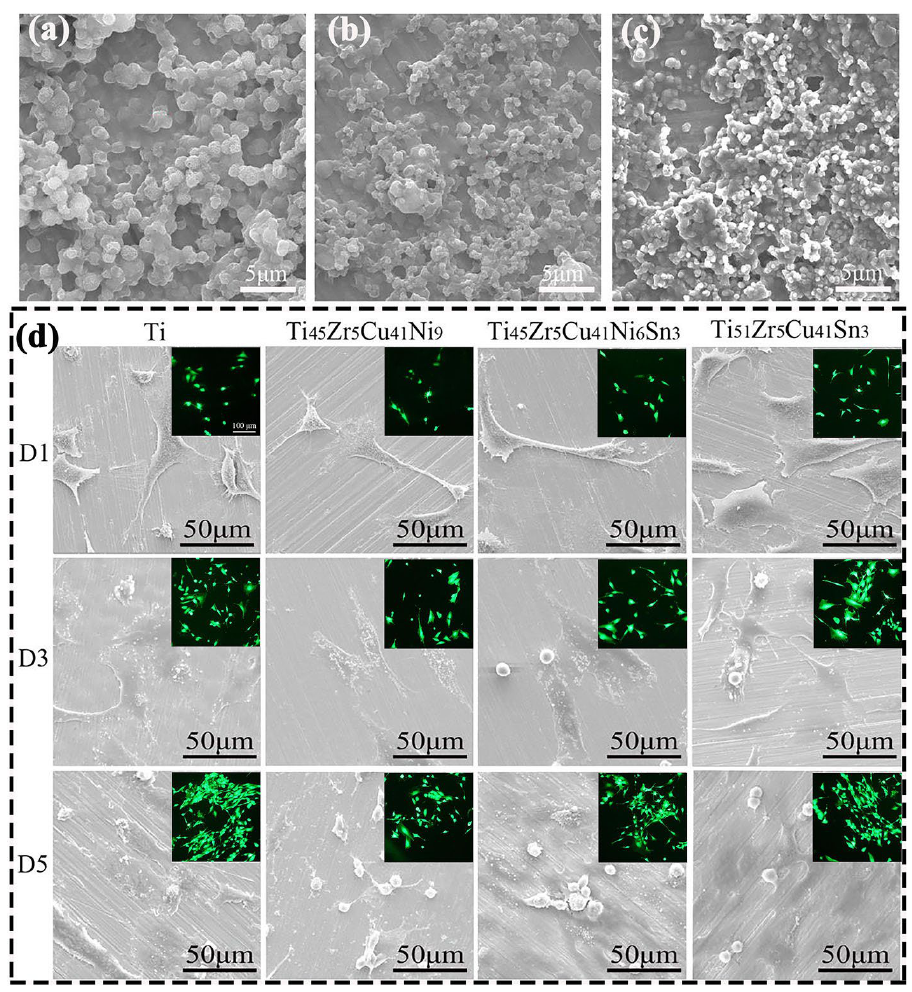
Figure 13. Surface morphology of a metallic glass composite coating immersed in SBF for 7 days: ( a ) Ti 45 Zr 5 Cu 41 Ni 9 coating; ( b ) Ti 45 Zr 5 Cu 41 Ni 6 Sn 3 coating; ( c ) Ti 51 Zr 5 Cu 41 Sn 3 coating; ( d ) morphology of osteoblastic cells cultured on the substrate and metallic glass composite coatings for 1, 3 and 5 day (inset images showing the fluorescence micrograph and the live cells stained with green) (reprinted from Ref. [236] with the kind permission of Elsevier).